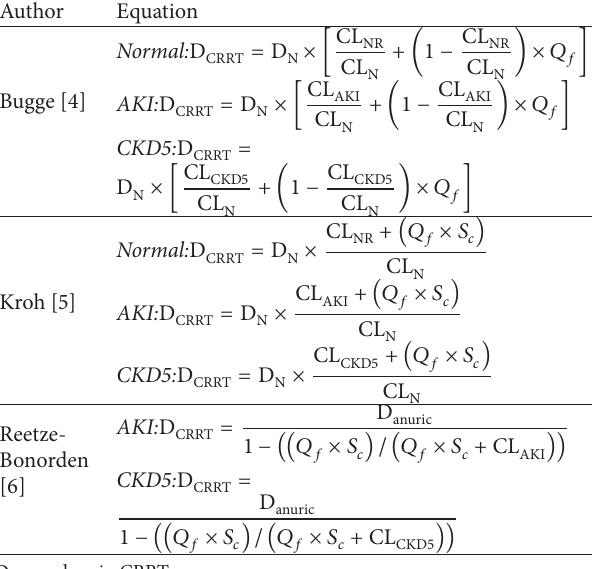
Table 1: Equations proposed for determining appropriate medica- tion dose for a patient undergoing continuous renal replacement therapy